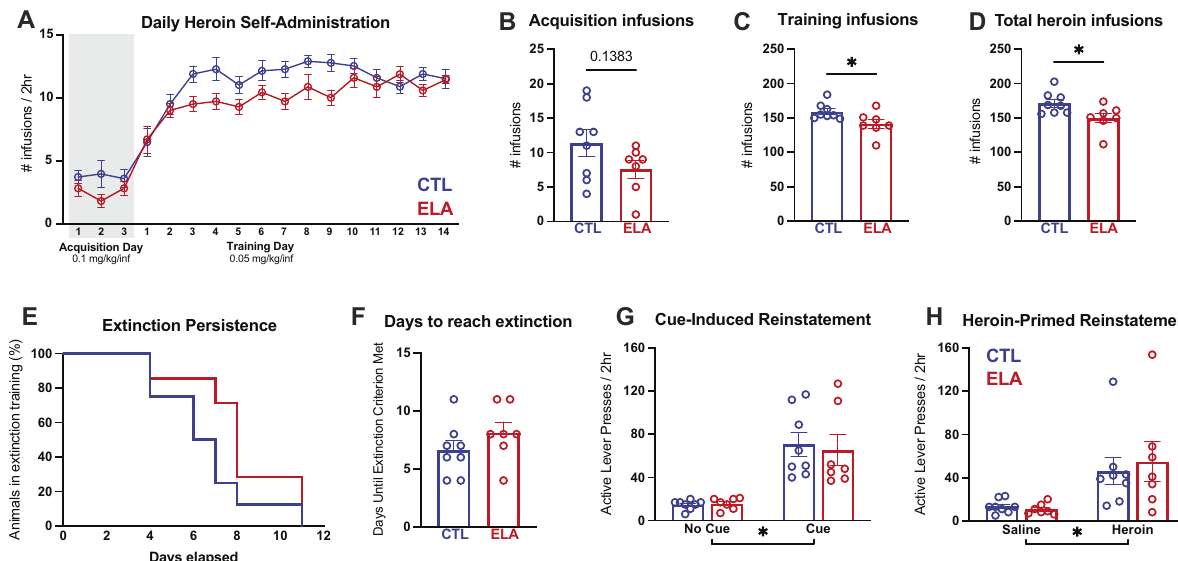
Fig. 2 ELA reduces heroin self-administration but not does not alter extinction or relapse. A Average daily heroin consumption. B There was a trend towards reduced consumption of heroin during the high-dose acquisition phase among ELA-reared animals. ELA led to reduced consumption during the training phase ( C ) and overall consumption ( D ). Despite reduced intake, ELA did not alter extinction ( E , F ) or reinstatement to heroin seeking ( G , H ). * ELA vs CTL P < 0.05. n = 8 CTL/7